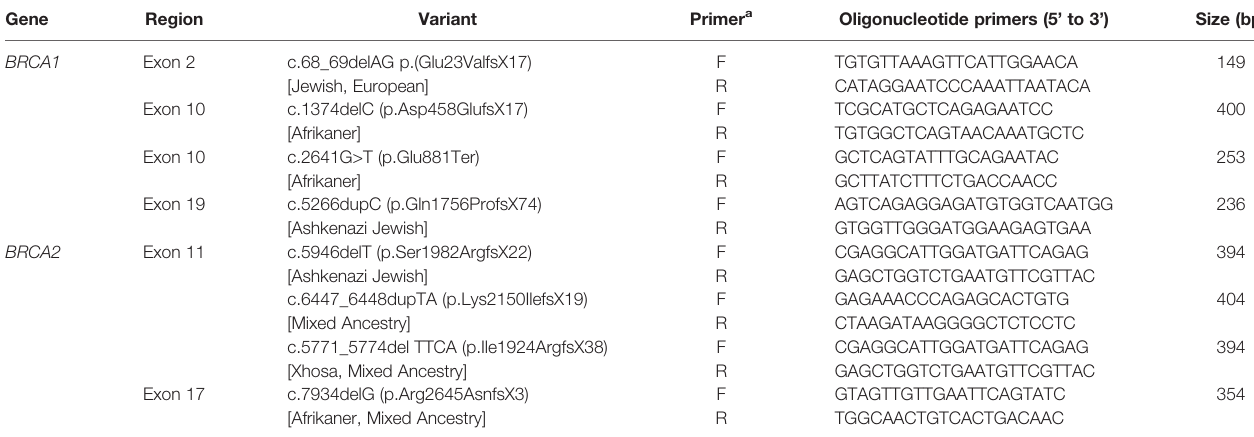
TABLE 2 | Oligonucleotide primers used for conventional polymerase chain reaction application and Sanger sequencing of BRCA1 (NM007294.4) and BRCA2 (NM000059.3) gene regions spanning the nucleotide positions of eight pathogenic founder/recurrent mutations previously identi fi ed in the multi-ethnic South African population. Gene Region